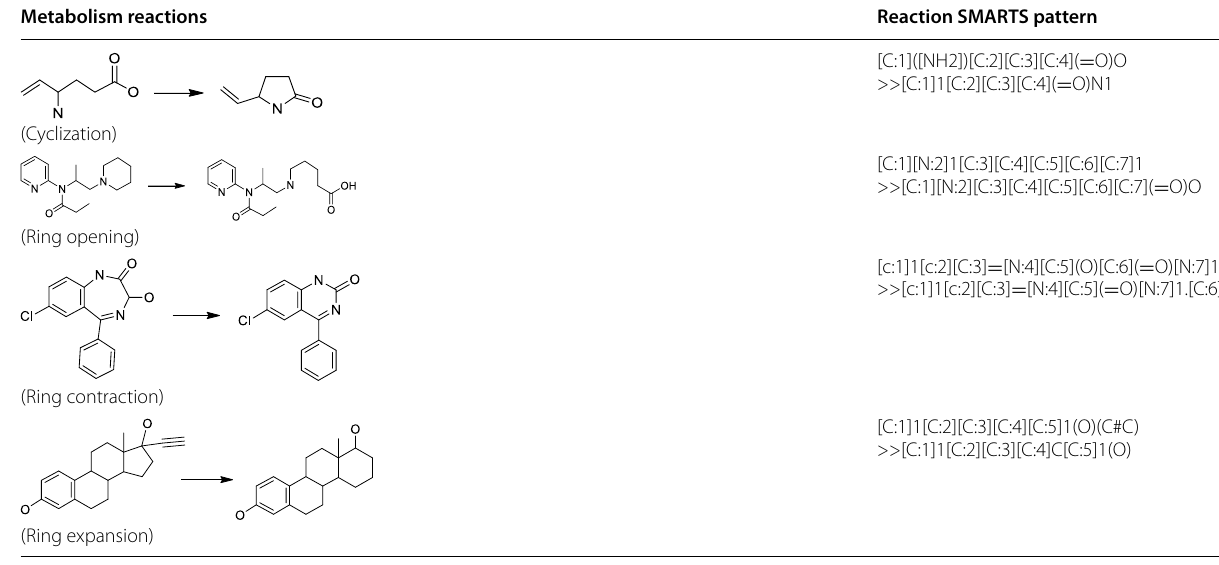
Table 3 Examples of the expressions of detailed reaction SMARTS pattern for complex ring